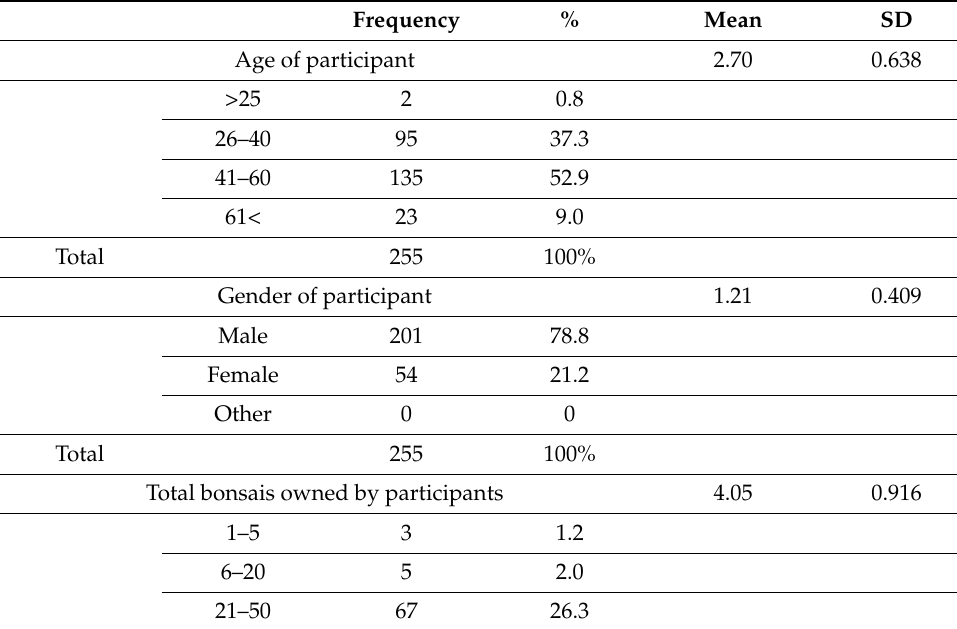
Table 1. Description of demographics of